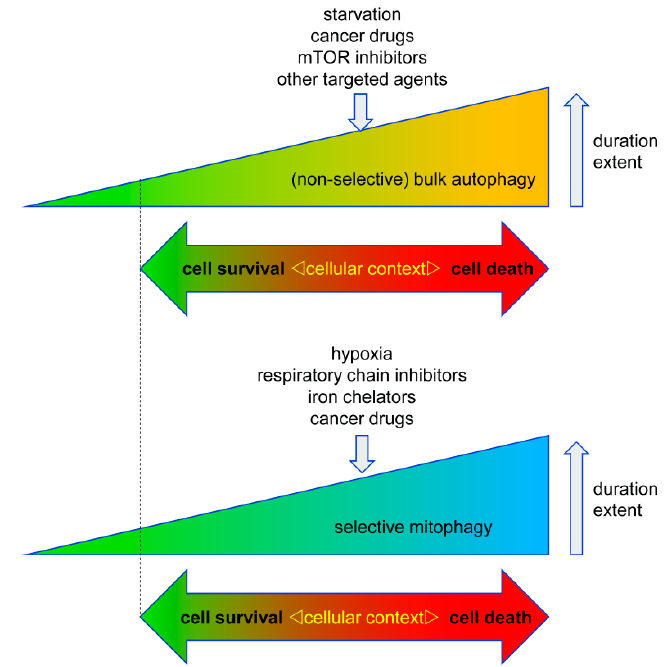
Figure 2. Context-dependent cell responses to bulk autophagy and selective mitophagy. Both autophagy and mitophagy can either promote or inhibit cell death in cancer cells. This response is highly dependent on the cell type, the trigger of auto- / mitophagy, its duration, and its extent. Accordingly, excessive autophagy can lead to cell death, however too little autophagy / mitophagy (marked by dotted line) can also be detrimental to the cells due to an impaired quality control / removal of harmful cellular material.